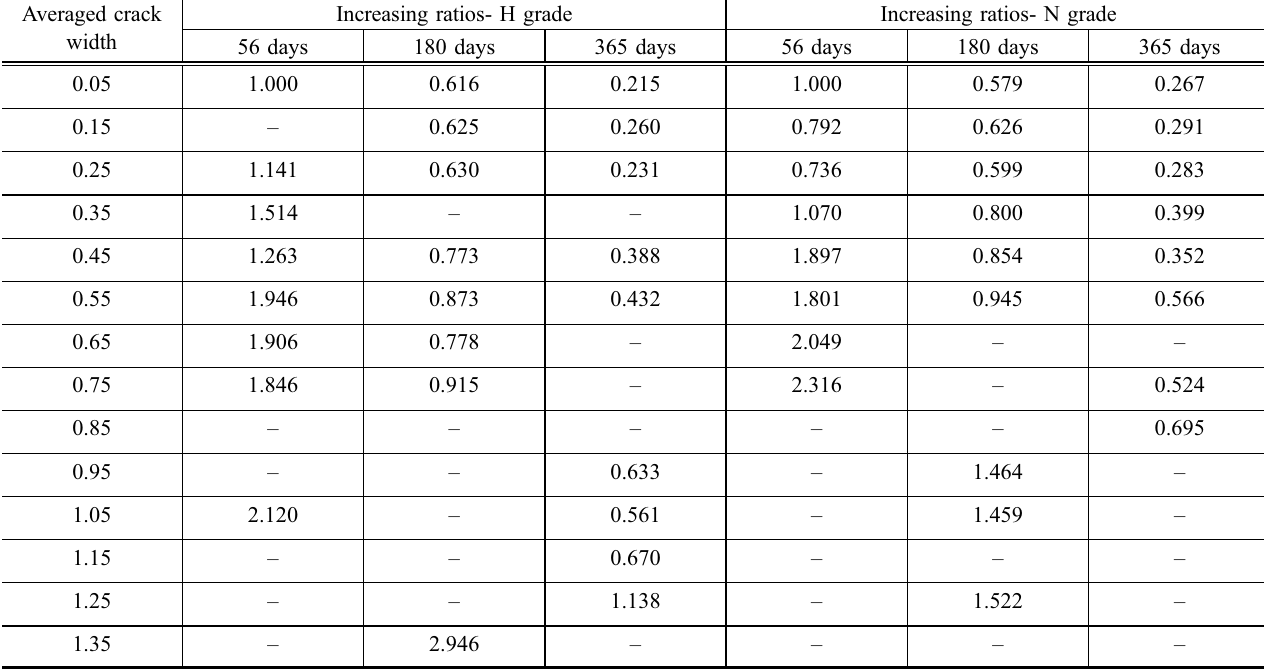
Table 4 Normalized crack width and diffusion